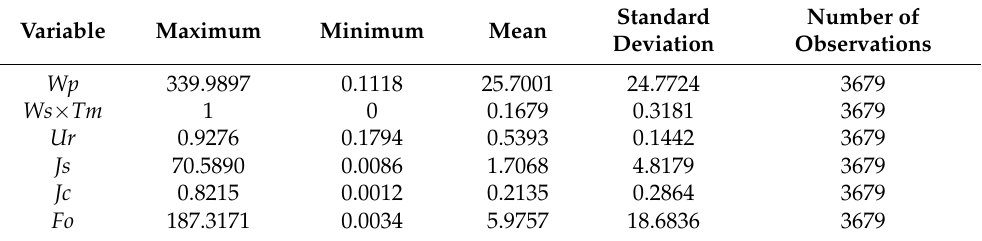
Table 2. Descriptive statistical